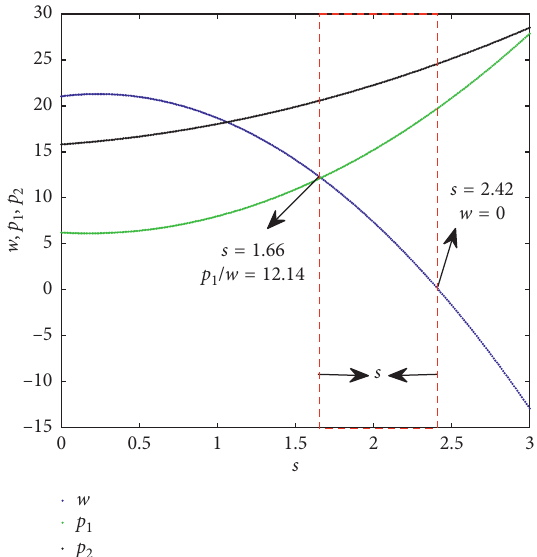
Figure 8: Nash equilibrium ( w,p